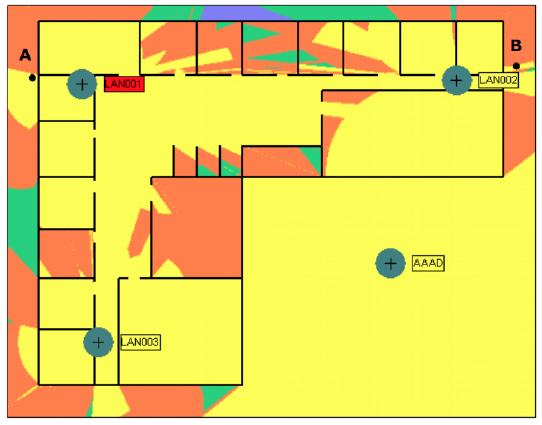
Figure 7. Heuristic site locations for indoor with multiple-input multiple-output (MIMO)